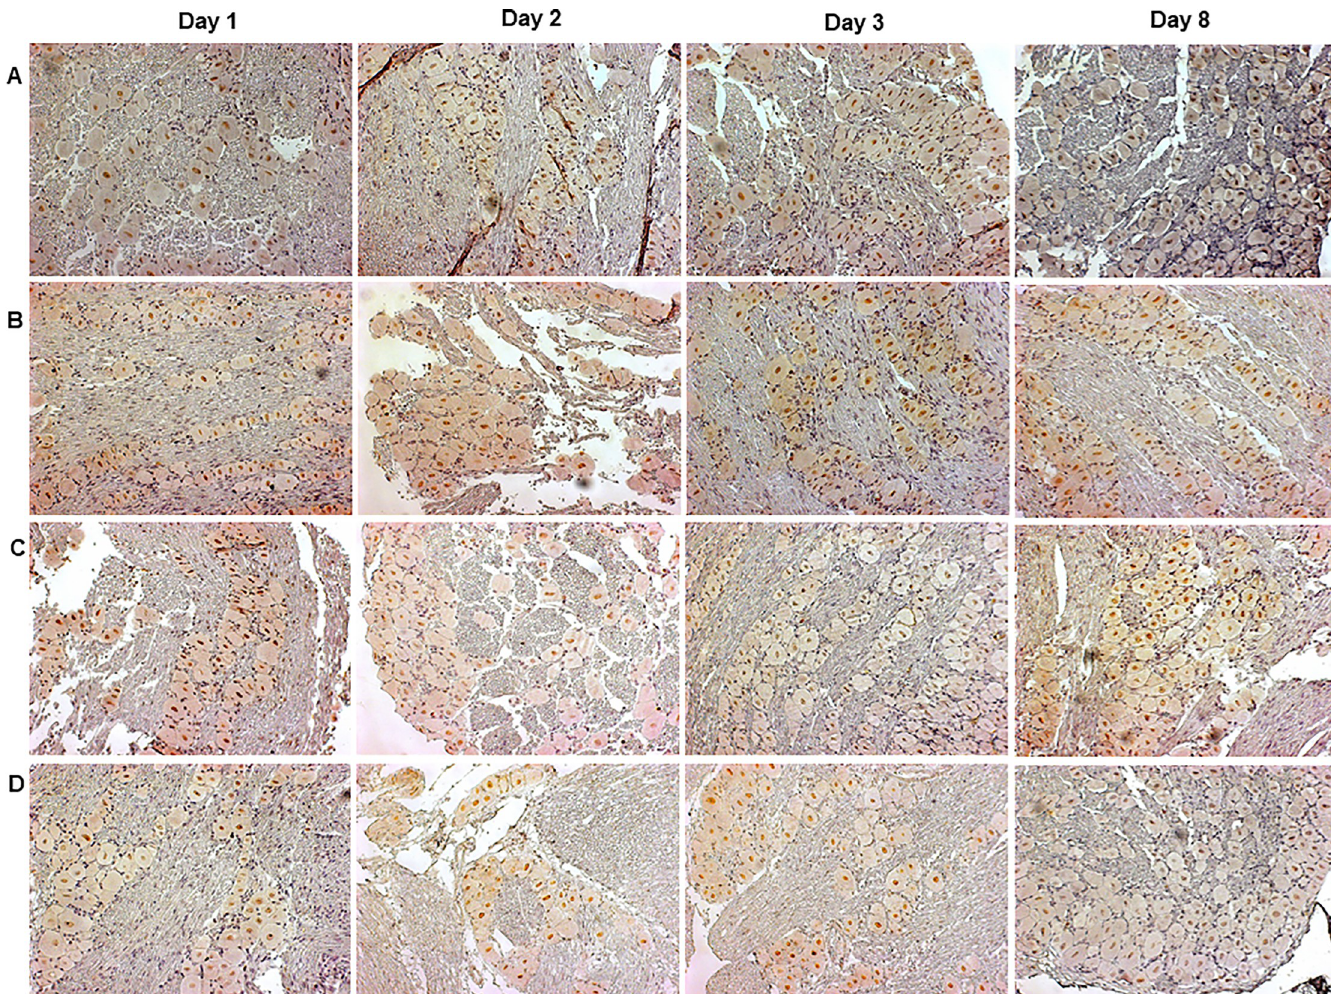
Fig 6. Neurons encircled by GFAP-immunopositive satellite cells, in the left trigeminal ganglion of rats. Na ï ve (A), open (B), closed (C) and CFA (D) groups, at 1, 2, 3 and 8 days after procedures.